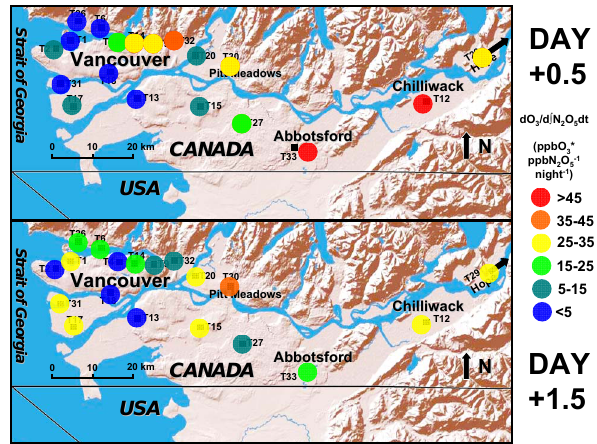
Fig. 12. Spatial variation in response of peak hourly average ozone at monitoring stations in the valley to overnight integral of N 2 O 5 with respect to time in the marine air at Saturna Is., for days follow- ing a nighttime integral. Day + 0.5 (top panel) and Day + 1.5 (bot- tom panel) correspond to the day immediately following a nighttime integral, and the day after that